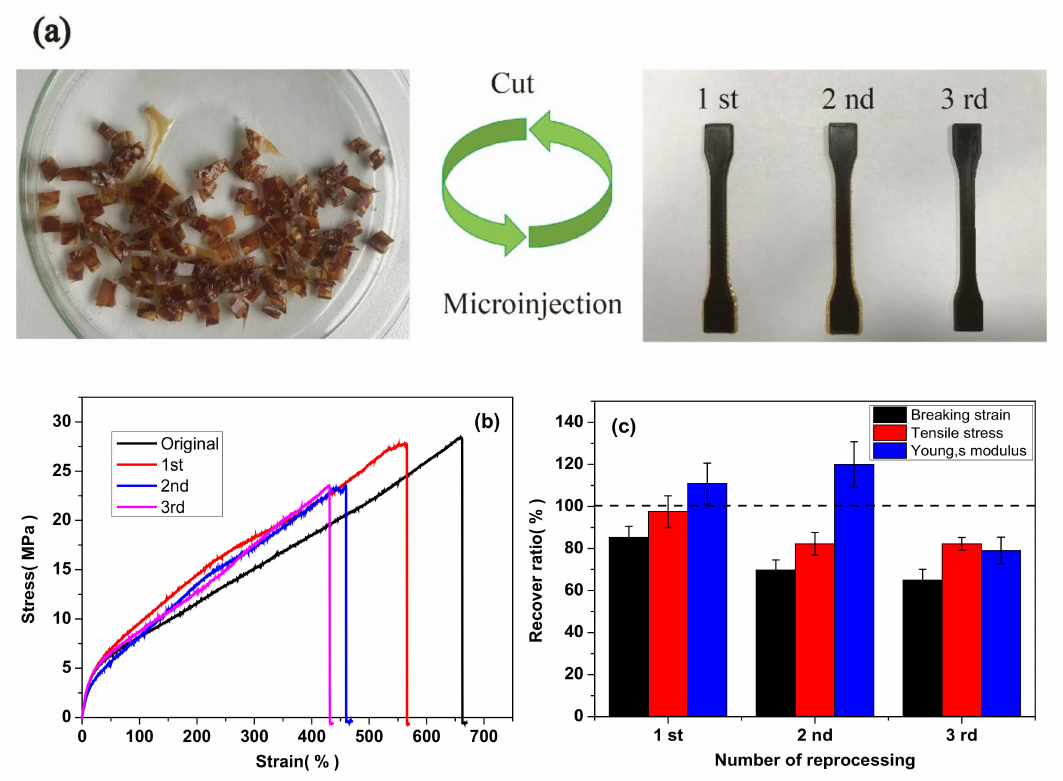
Figure 13. ( a ) Optical images of thermal recycling performance of semi IPNs 6%CPSFTPU 1 , ( b ) mechanical properties of the samples with different generations: tensile curves and ( c ) recovery